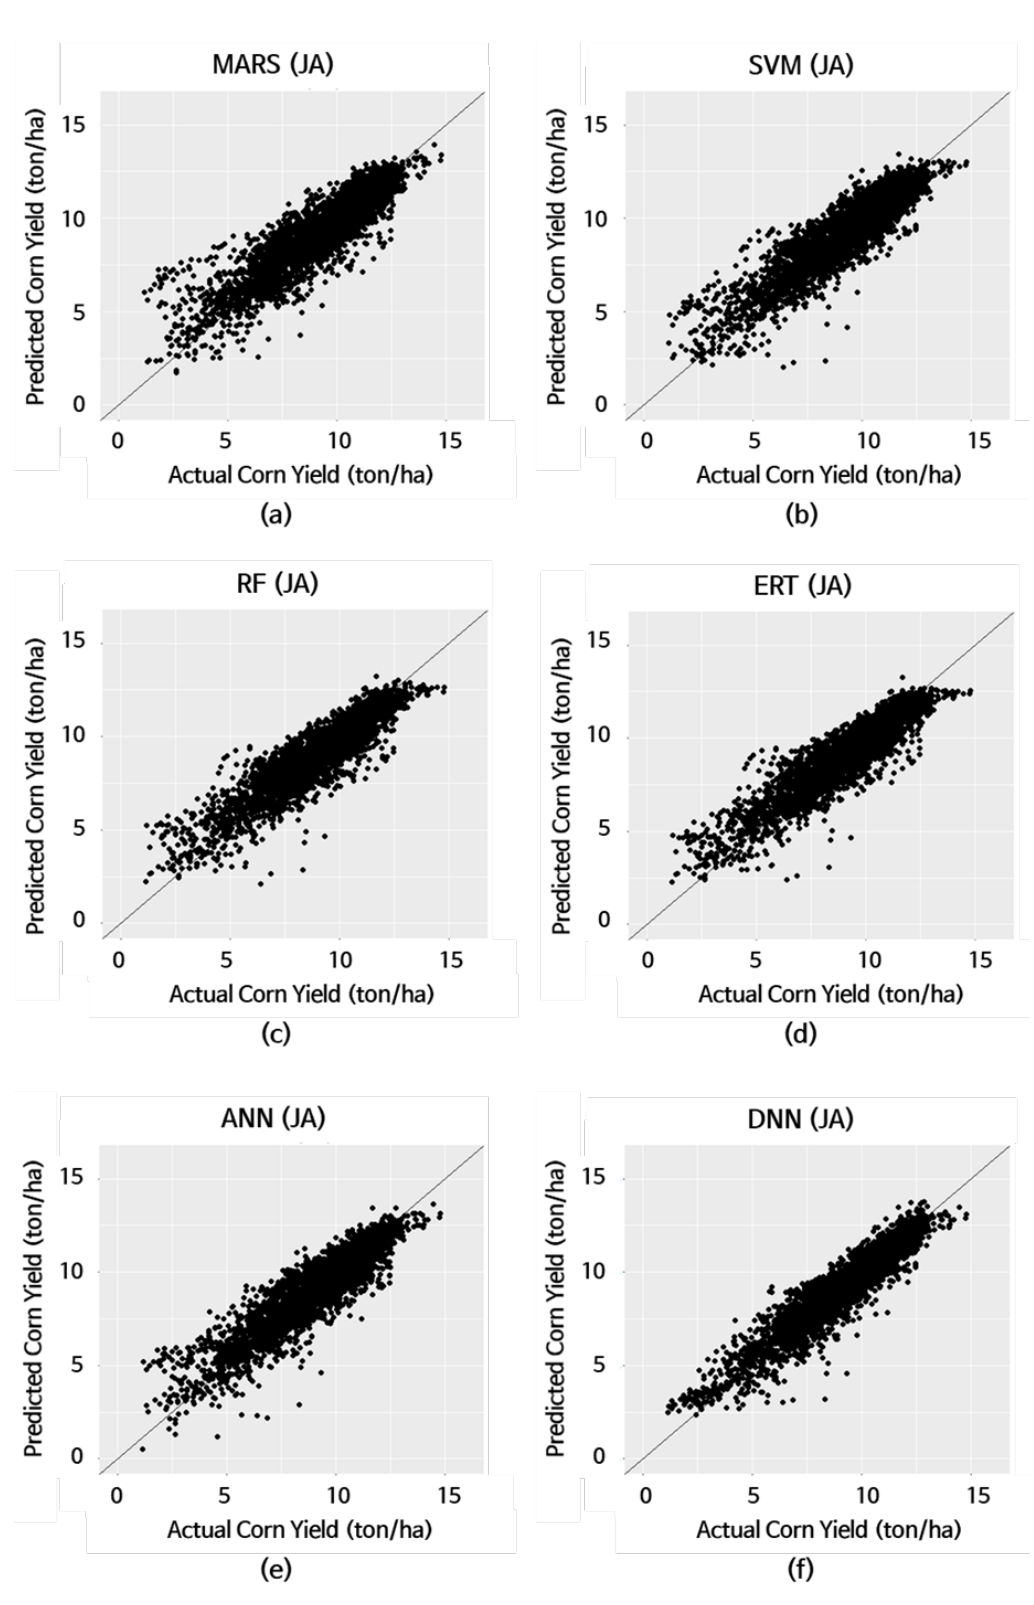
Figure 5. Actual versus predicted corn yields from 10 rounds of experiments for July–August (JA) (major productive period), 2006–2015: ( a ) multivariate adaptive regression splines (MARS), ( b ) support vector machine (SVM), ( c ) random forest (RF), ( d ) extremely randomized trees (ERT), ( e ) artificial neural network (ANN), and ( f ) deep neural network (DNN).